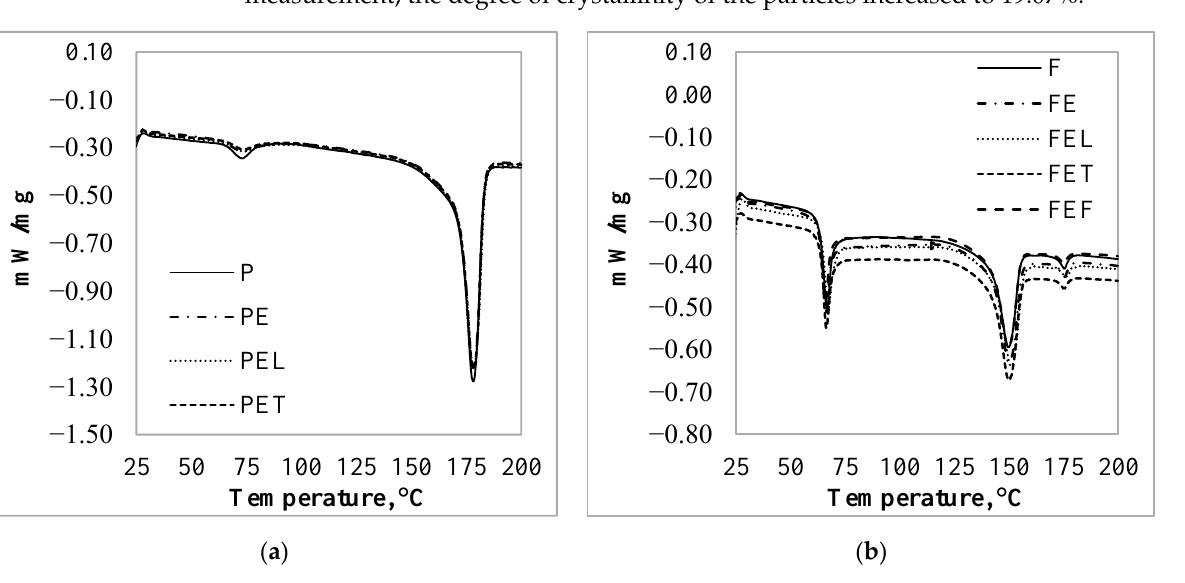
Figure 7. PLA microparticles first heating DSC curves after the adsorption measurement: ( a ) 3D850 granules; ( b ) 4043D granules.